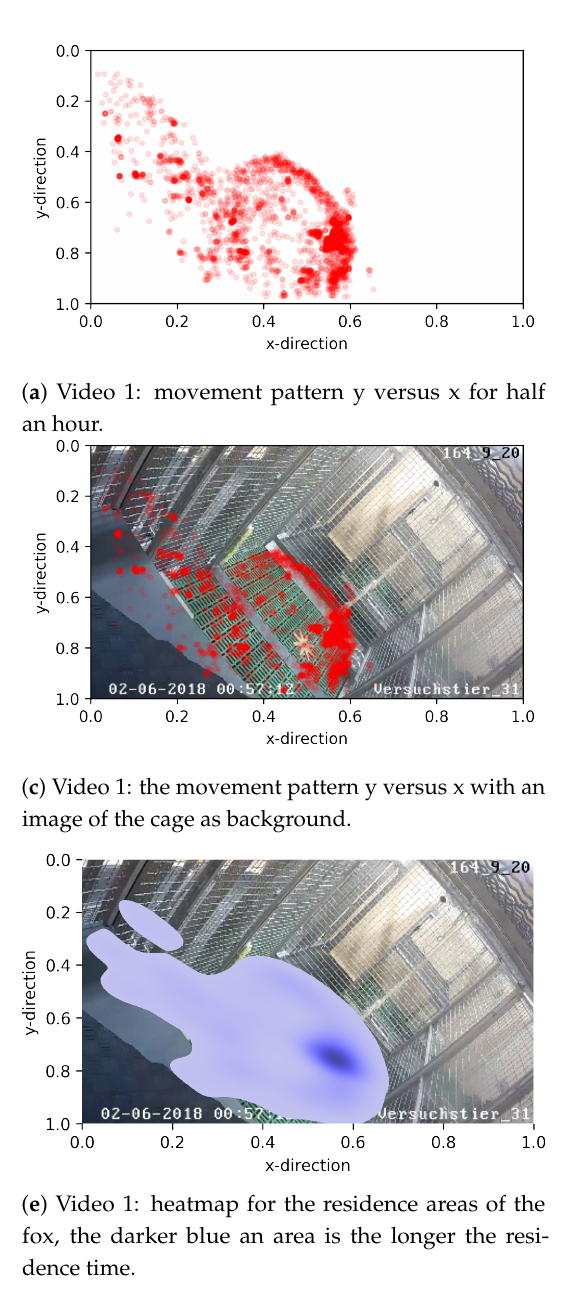
Figure 6. Movement patterns y versus x of video 1 and 2, respectively, with half an hour time period. Subsequently, the x- and y-coordinates were used to generate heat maps for the residence places of foxes (Figure 6e,f), whereby the intensity of the color depicts areas with the higher residence periods. As seen in plot Figure 6e, the dark blue area at position (0.55, 0.8) corresponds to the scratching-on-ground phase in video 1, during this phase the foxes stayed at the same place for a long time. The dark blue area at position (0.4, 0.3) of Plot Figure 6f corresponds to the sleeping place of the fox in video